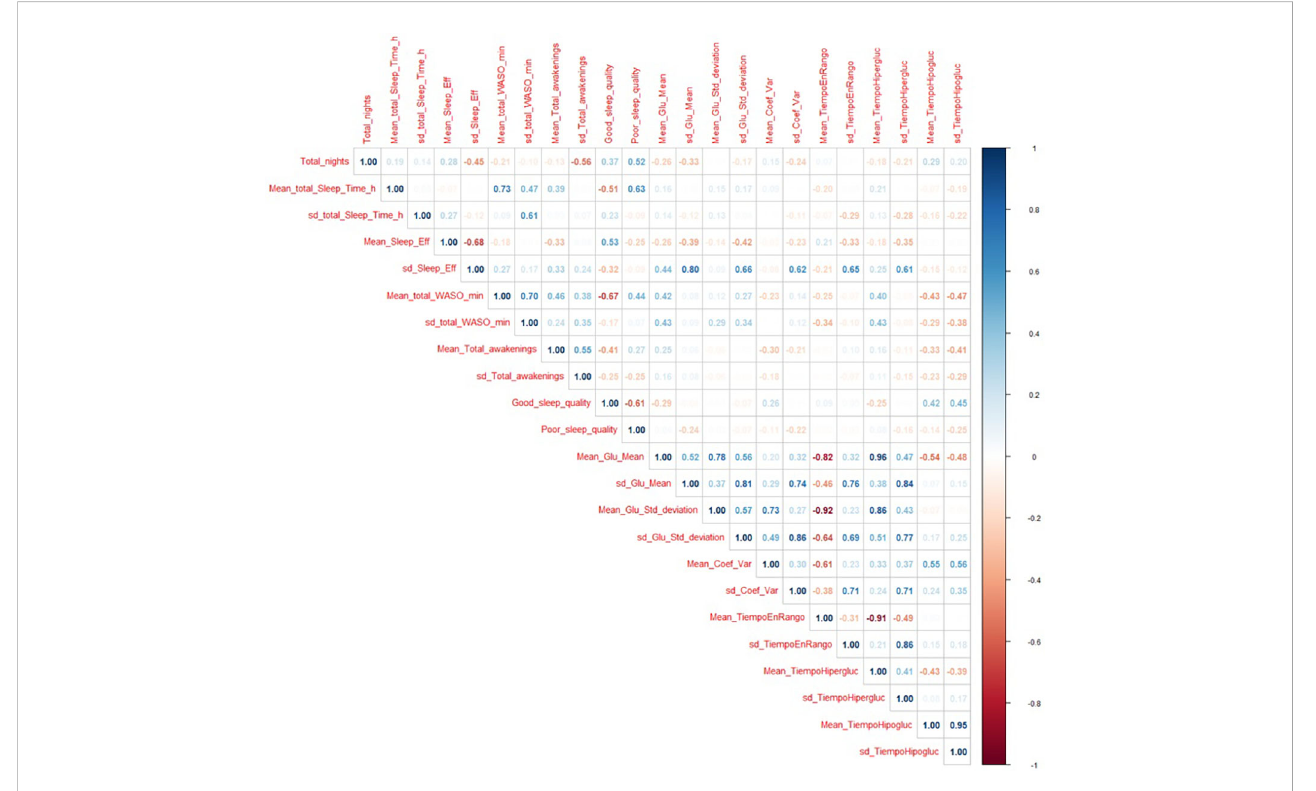
FIGURE 2 Correlation matrix for all the variables recorded in this